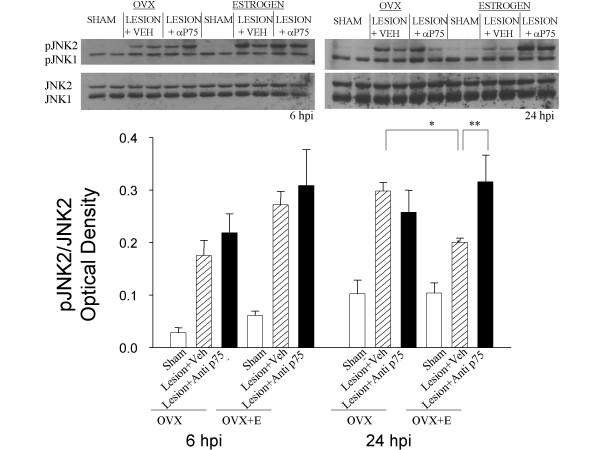
JNK activity following olfactory bulb lesions: JNK activation was measured by Western blot assay using phospho-specific (p) antibodies, and pJNK2 expression was normalized to total JNK2 protein. JNK1 was constitutively active in all cases. Virtually no pJNK2 was seen in the sham-injected controls in either control or estrogen-replaced animals. Bulb lesions significantly increased pJNK2 at 6 h after the lesion. At 24 h, pJNK2 levels were still elevated in the control-replaced (OVX) lesioned animals but significantly attenuated in the estrogen-treated (OVX+E) lesioned group. Anti-p75NTR reversed the effects of estrogen on pJNK2 activation at 24 h, although it had no effect on the control-pellet group. Two representative examples are shown from each treatment condition in the Western blot images. Histogram bars represent means+SEM for the entire group (n = 6). Sham: Sham lesion, Lesion+Vehicle: NMDA injection with pre immune serum, Lesion+Anti p75: NMDA injections with anti-p75NTR antibodies. *:p < 0.05.